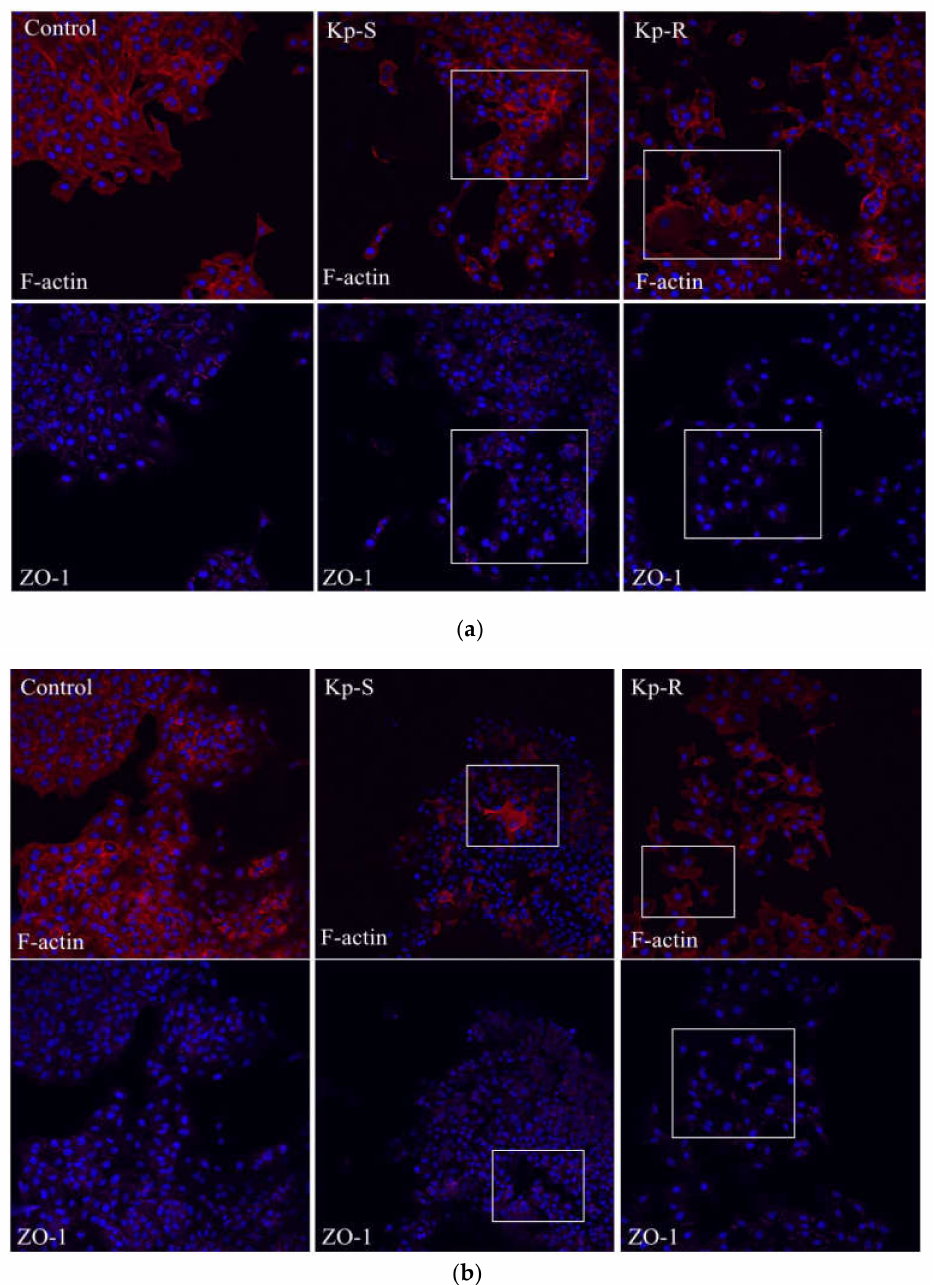
Figure 3. Cytoskeleton protein F-actin and tight-junction protein Zo-1 were stained in Kp-S and Kp-R-infected A549 cells. ( a ) Immunofluorescence staining of F-actin and Zo-1 12 h post-infection. ( b ) Immunofluorescence staining of F-actin and Zo-1 16 h